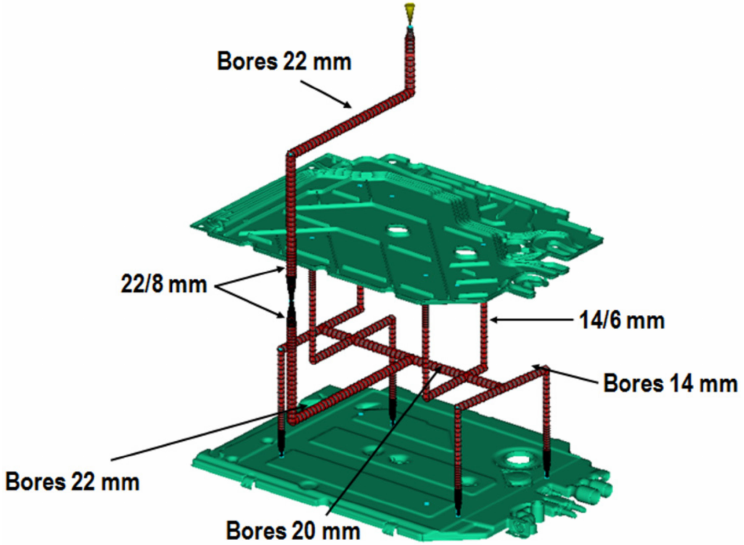
Figure 8. An example of the construction of a plastic feed system in an injection